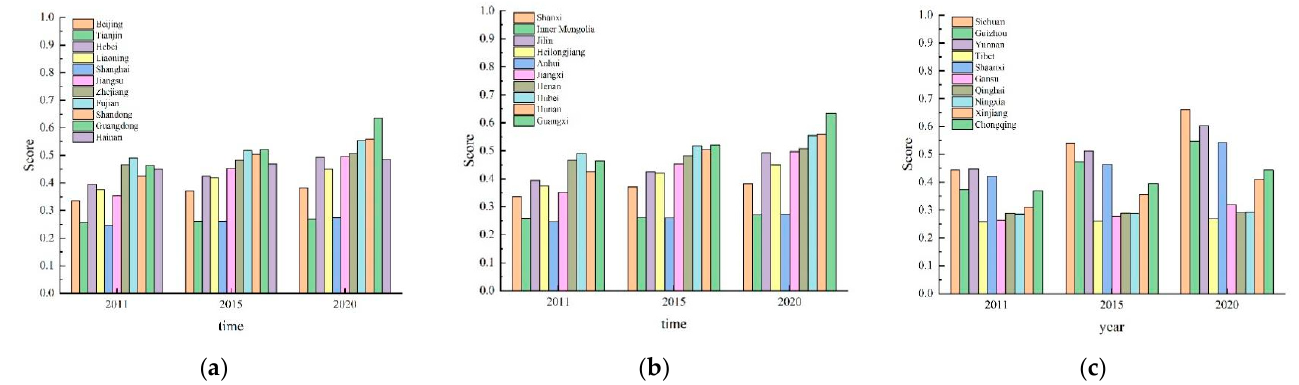
Figure 1. Agricultural environment score map of the ( a ) eastern, ( b ) central, and ( c ) western regions. From Figure 1, in the eastern region, Zhejiang, Fujian, Guangdong, and Hainan show a significant lead in the agricultural environment, whereas the agricultural environment in Tianjin and Shanghai is not ideal [11]. The overall environmental change in the eastern region is not large. The overall level is also relatively backward compared with the central and western regions, which shows that the eastern region does not pay considerable at- tention to the development of agriculture [12]. Environmental construction has reached a good level. Particularly, Henan developed rapidly between 2015 and 2020, and the envi- ronmental conditions of each region have developed well between 2011 and 2020 and have made great progress. In the western region, the north and south sides also show great differences. The environmental conditions in Tibet, Gansu, Qinghai, Ningxia, and Xinjiang are all at a relatively low level, and the environmental conditions have not changed significantly in 10 years [13], whereas the levels in southwestern regions, such as Sichuan and Guizhou, are at a relatively low level. Moderate and large improvements are observed over 10 years. 4. Coupling Coordination Degree of China’s Agricultural Environment and Economy The coupled coordination degree model is used to analyze the coordinated develop- ment level of subjects. Coupling degree refers to the interaction between two or more sys- tems to achieve a dynamic relationship of coordinated development, which can reflect the degree of interdependence and mutual restriction between systems. The degree of coor- dination refers to the degree of benign coupling in the coupling interaction relationship, which can reflect the quality of coordination. The agricultural economic growth index is represented by the per capita output value of agriculture, forestry, animal husbandry, and fishery (total output value of agriculture, forestry, animal husbandry, and fishery/persons engaged in the primary industry), considering population changes. At the same time, to consider the influence of inflation on agricultural economic growth, the gross output value is calculated using the constant price in 2011 as the base period [14]. The coupling degree between the comprehensive agricultural environment index and agricultural eco- nomic growth index in each province from 2011 to 2020 is calculated [15]. The coupling and coordination status of China’s agricultural environment and economy in 2020 is shown in Table3. Table 3. 2020 agricultural economy and environment coupling coordination degree. Province